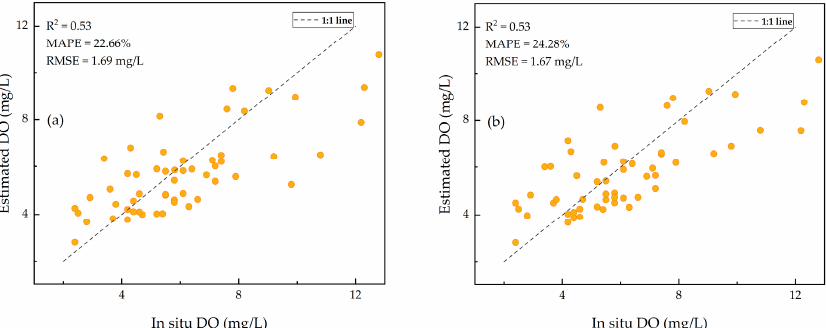
1.67mg/L) (Figure 8).